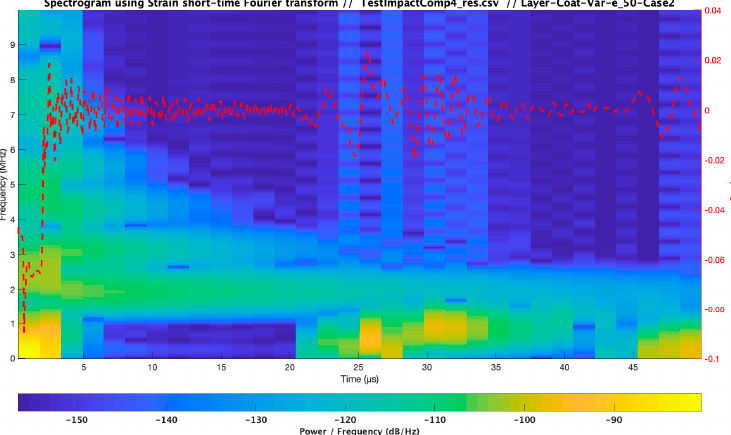
Figure 29. Spectrogram for strain evolution at the middle coating layer, 50% thickness, considering substrate-filler as semi-infinite with variation in coating modulus. Case 2.